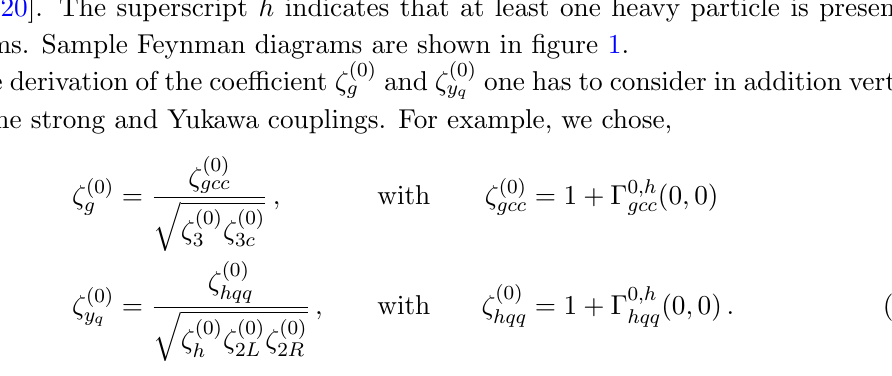
Figure 1. Sample diagrams contributing to (cid:16) 3 , (cid:16) 2 L; 2 R , (cid:16) m and light Higgs ( h ) as external